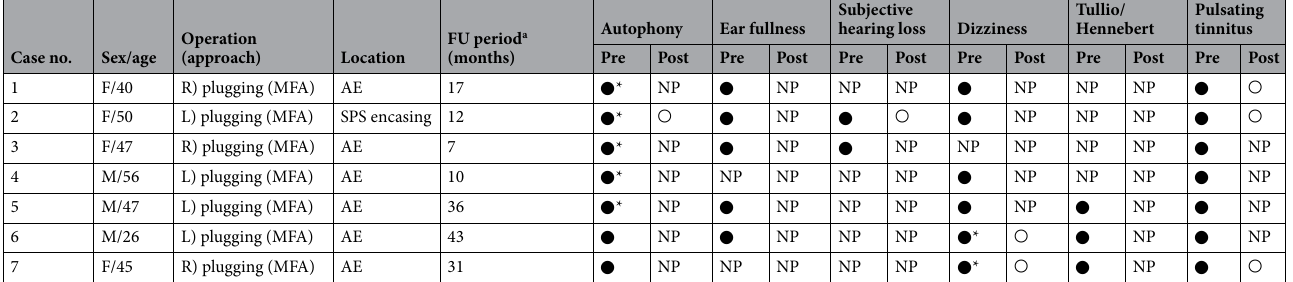
Table 1. Demographics and clinical characteristics of patients with superior semicircular canal dehiscence. M male, F female, R right, L left, B bilateral, MFA middle fossa approach, AE arcuate eminence, SPS superior petrosal sinus, FU follow up, NP not present, present, ○ improved but remained. *Chief complaint. a Note that refers to period of follow-up from the surgery to the present. The status if postoperative symptoms after ● surgery is based on the